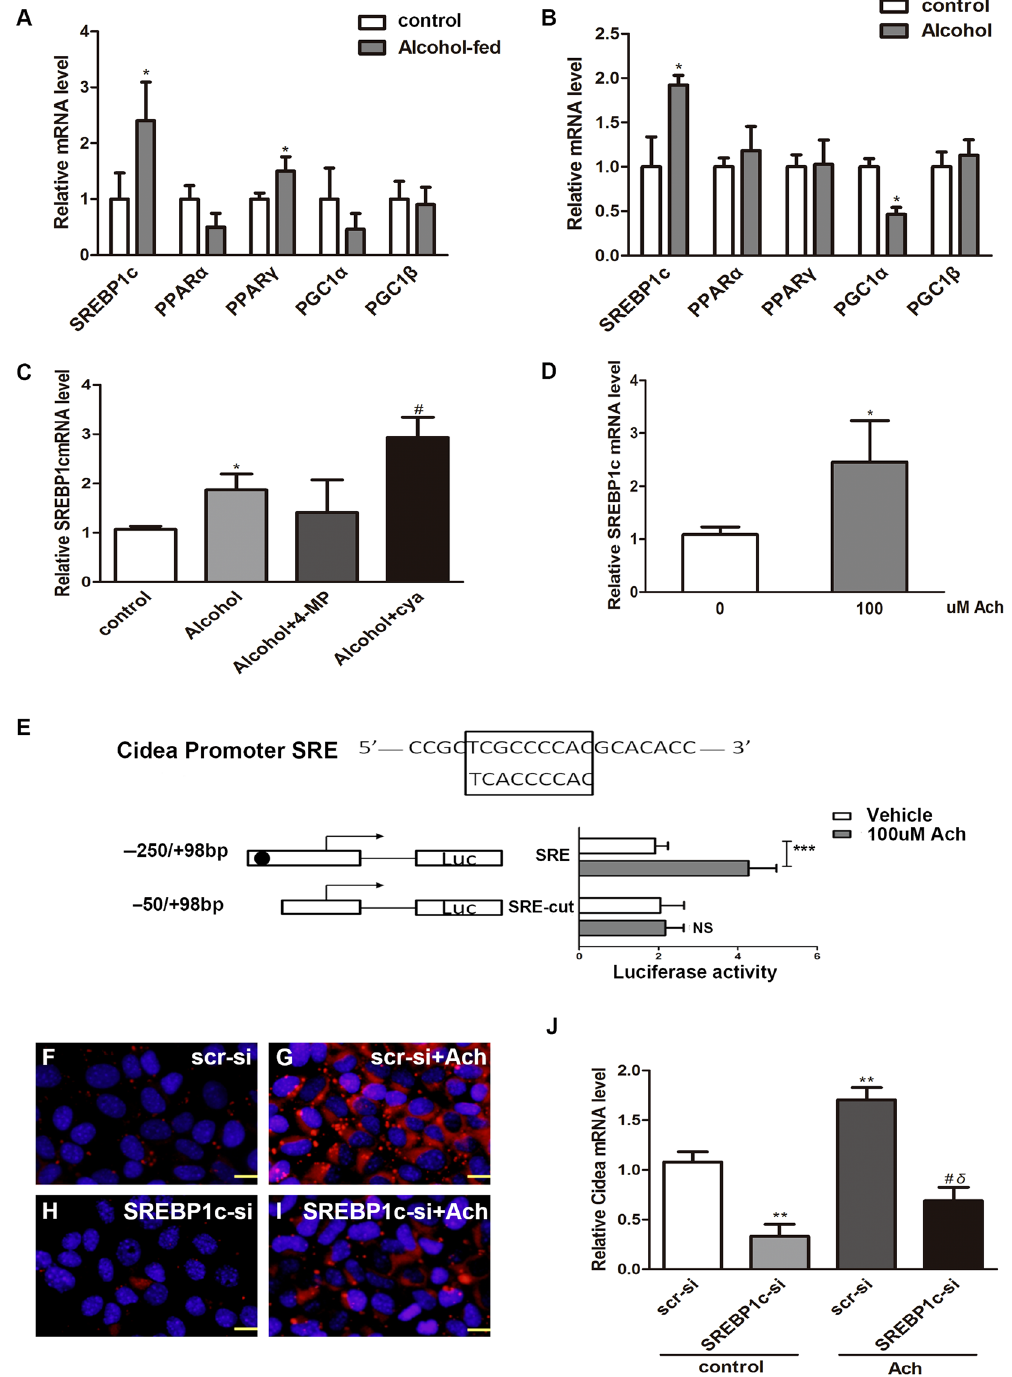
Figure 4. SREBP1cmediated acetaldehyde-induced Cidea expression. qPCR analysis of relative mRNA levels of key transcription factors levels in the livers of AF mice ( A ) and ( B ) Alcohol-treated AML12 cells were measured. Means ± SD, n = 4–5 mice per group, * p < 0.05; NS, not significant. ( C ) SREBP1c mRNA levels were measured in AML12 cells. Means ± SD, n = 3, * p < 0.05 vs. control group; # P < 0.05 vs. Alcohol group; NS, not significant. ( D ) AML12 cells were treated with 100 uM acetaldehyde for 48 h, SREBP1c mRNA levels were measured. Means ± SD, n = 3, * p < 0.05 vs. control group. ( E ) HepG2 cells were treated with 100uM acetaldehyde for 48 h. Then Luciferase reporter plasmid were transfected into HepG2 cells with Lipofectamine 2000. Means ± SD, n = 6, *** p < 0.001; NS, not significant. ( F – I ) Nile red staining (X200) and ( J ) Cidea mRNA and in AML12 cells with or without SREBP1c knockdown in the presence or absence of acetaldehyde. Means ± SD, n = 3, ** p < 0.01 vs. scr-si group; # P < 0.05 vs. scr-si + Alcohol group; δ < 0.05 vs. SREBP1c-si group. scr-si, scrambled siRNA; SREBP1c-si, SREBP1c